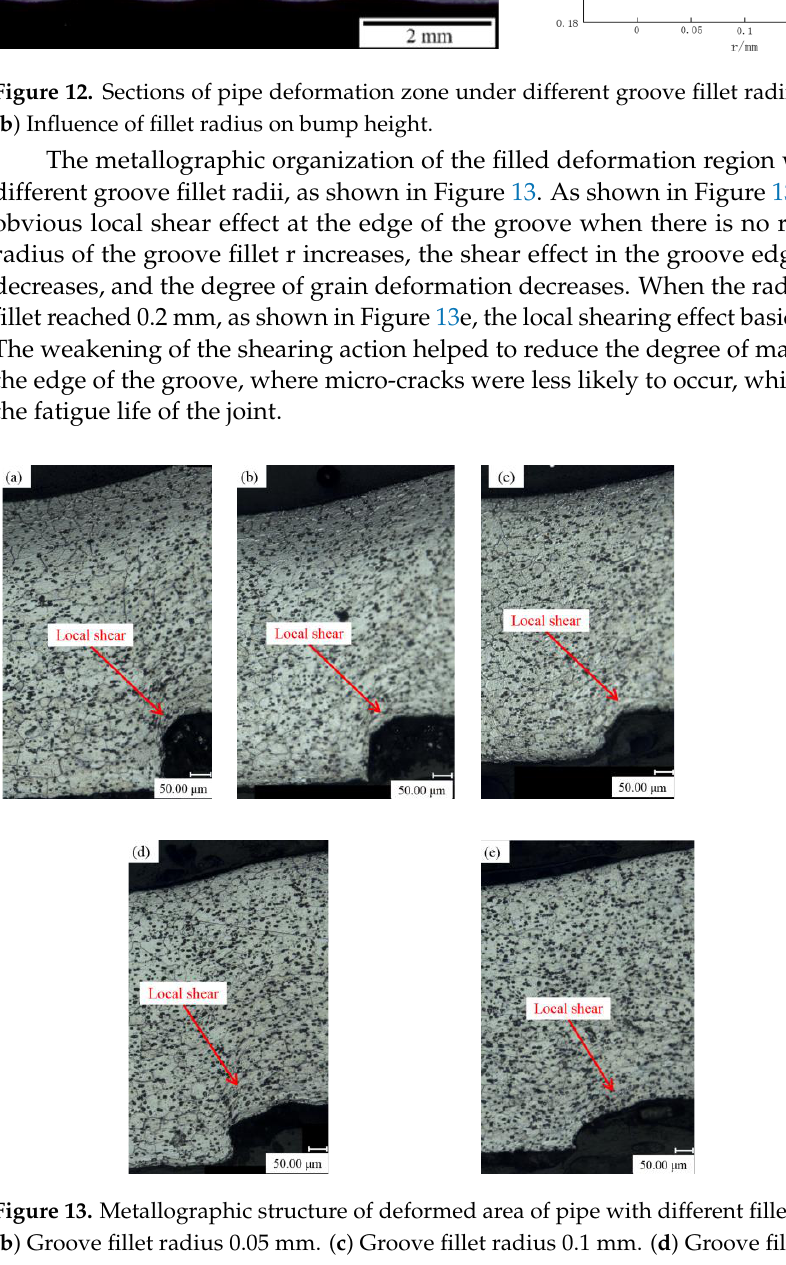
Figure 12. Sections of pipe deformation zone under different groove fillet radii. ( a ) Actual photo; ( b ) Influence of fillet radius on bump height.